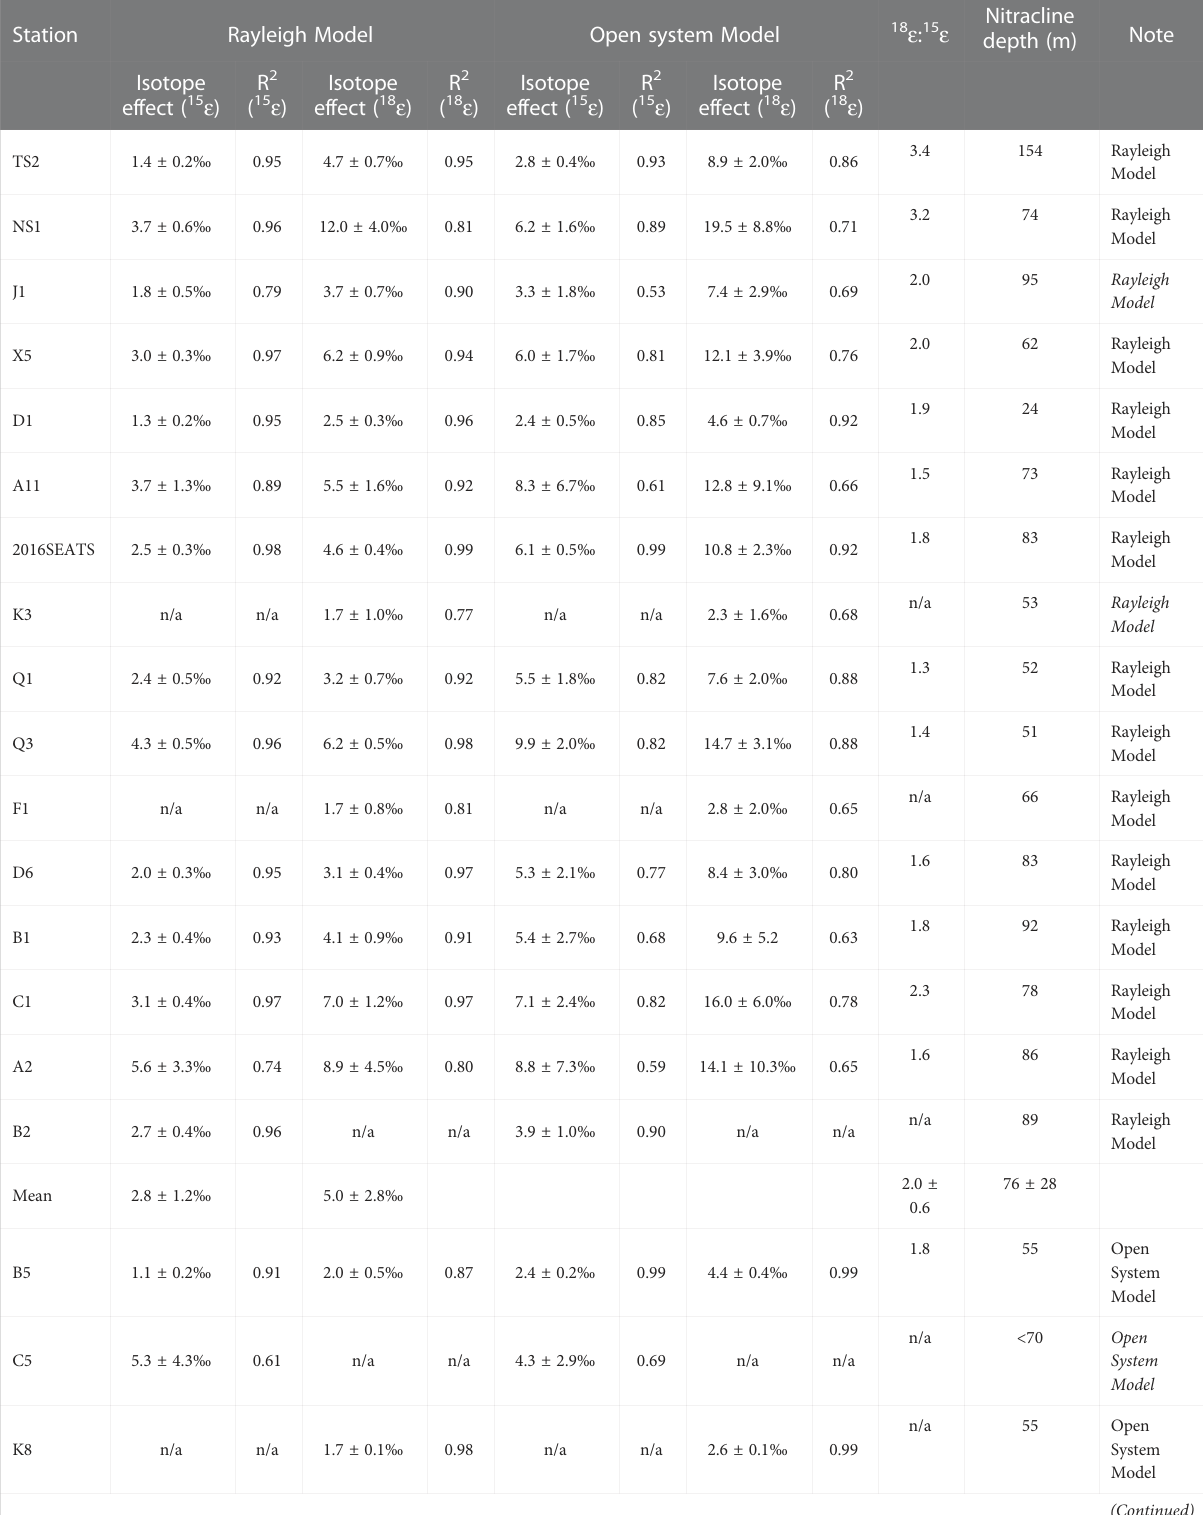
TABLE 1 The isotope effect of NO 3 – assimilation estimated from the Rayleigh Model and the Open system Model at appropriate stations.